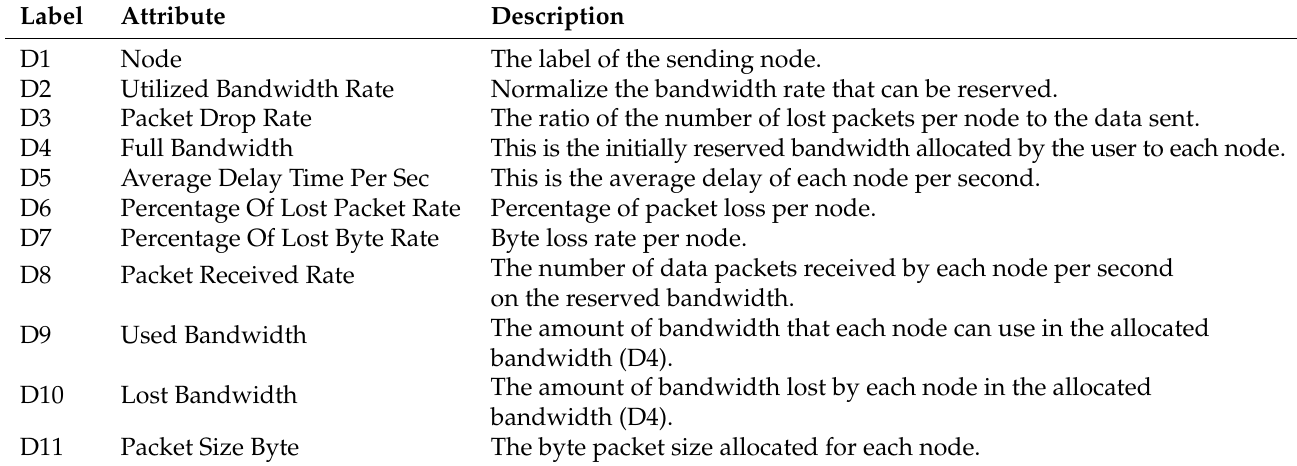
Table 1. Packet data